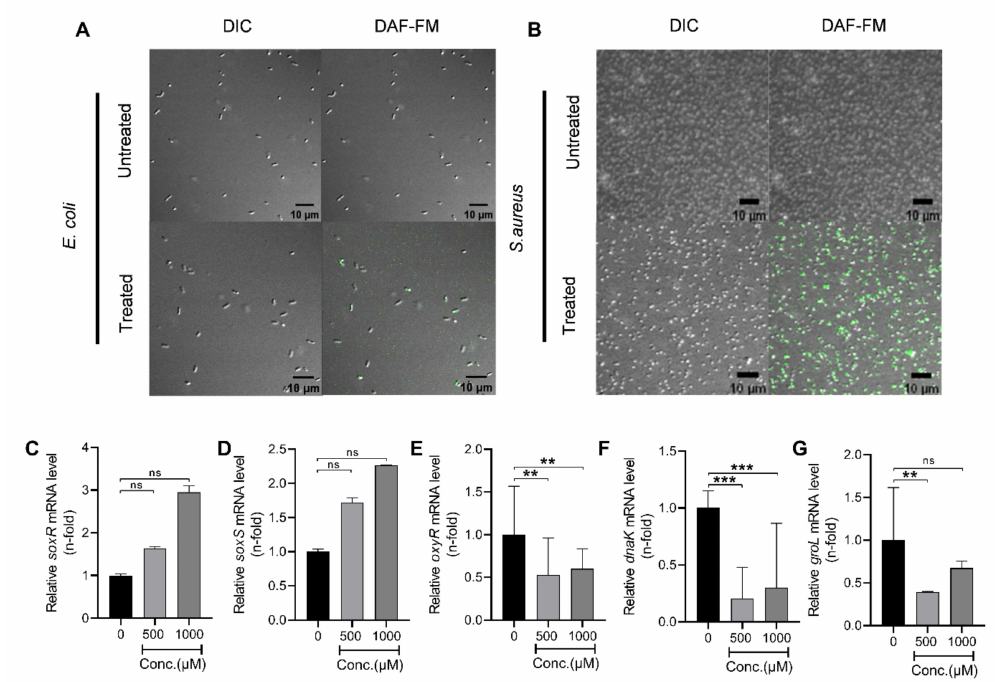
Figure 6. Reactive oxidative and nitrosative species formed by PG-NOW disrupt the homeostasis of bacterial cells. Intracellular levels of RNS in ( A ) E. coli and ( B ) S. aureus after PG-NOW treatment was observed using the DAF-FM DA assay, in which a fluorescent benzotriazole was seen. ( C , D ) Analysis of the nitrosative and oxidative stress regulons’ ( soxR and soxS) mRNA expression in E. coli , and ( E ) oxyR , respectively. The heat shock genes ( F ) dnaK , and ( G ) groL mRNA expression following the PG-NOW treatment (1000 µ M). ** p < 0.01, *** p < 0.001 vs. control or untreated, ns = not significant. The data are represented as the mean ± SD of three identical experiments with three